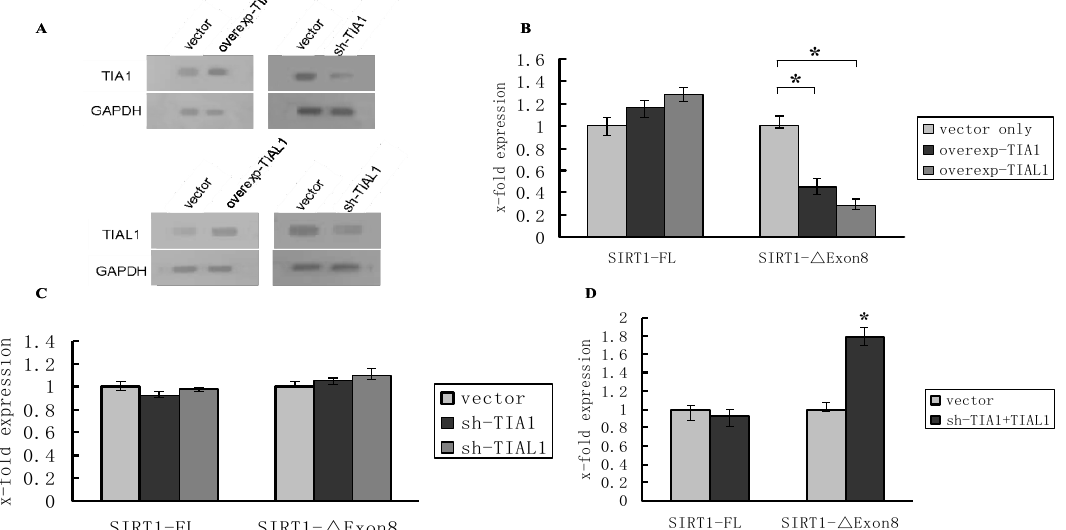
Figure 3. TIA1/TIAL1 regulates the SIRT1-∆Exon8 mRNA levels in 293T cells detected by Real-Time PCR. ( A ) The TIA1/TIAL1 protein levels after TIA1/TIAL1 overexpression or silencing in 293T cells; ( B ) Over-expression of TIA1/TIAL1 decreased the levels of SIRT1-∆Exon8 for about 60% and 70%, respectively; ( C ) The levels of SIRT1-FL and SIRT1-∆Exon8 mRNA had no significant differences after depletion of either TIA1 or TIAL1; ( D ) Reducing the levels of TIA1 and TIAL1 simultaneously resulted in SIRT1-∆Exon8 increase. * p < 0.05 compared to transfect corresponding vector